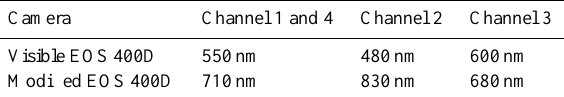
Table 1. Wavelengths of maximum spectral sensivity λ c of the two cameras. The measurements of camera spectral sensitivity (Demircan et al., 2000) have been conducted using a monochro- matic source and a spectro-gonioradiometer (Brissaud et al., 2004). In this study, the spectral sensitivity of each channel is approxi- mated by a Dirac delta distribution δ λ c